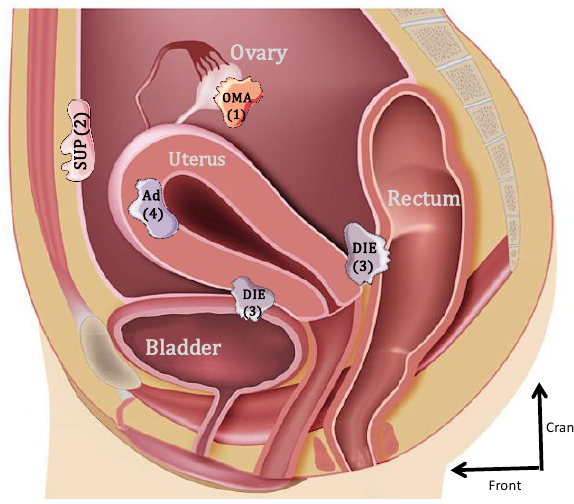
Figure 1. Schematic lateral view of the pelvis illustrating the 4 forms of endometriosis: 1: endometrioma (OMA); 2: superficial peritoneal endometriosis (SUP); 3: deep subperitoneal infiltrating endometriosis (DIE); 4: adenomyoma (Ad).